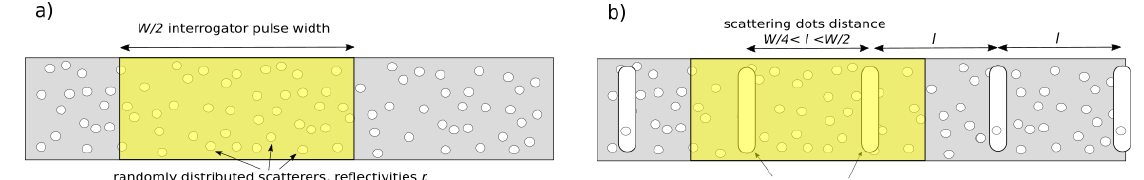
Figure 1. Sketch illustrating the difference in arrangements between an unmodified standard optical fiber and a modified scattering dot fiber using standard coherent optical time domain reflectometry (C-OTDR). ( a ) unmodified standard fiber, ( b ) scattering dot